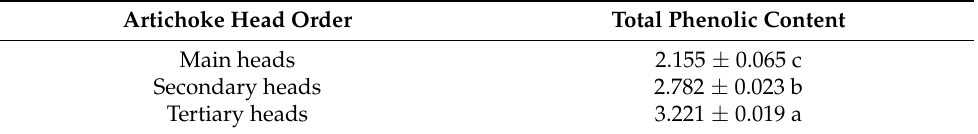
Table 3. Total phenolic content (g kg − 1 ) for different artichoke head orders (main, secondary, and tertiary heads) of ‘Lorca’ cultivar.